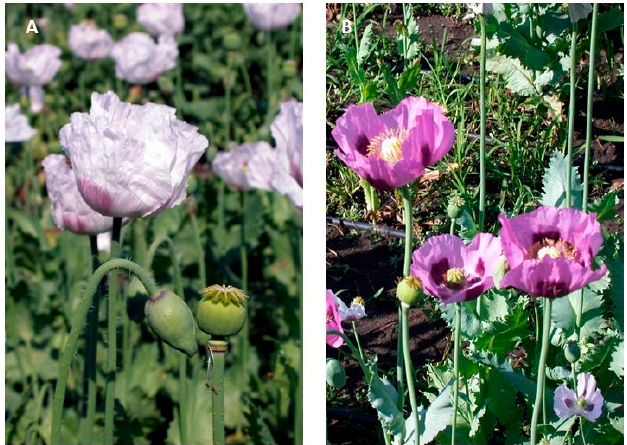
Figure 4. Color of opium poppy flowers may vary from white to purple. An example is shown for light violet flower ( A ) of cultivar ‘Korona’ and for dark purple flower ( B ) of cultivar ‘Leila’ (Photo: Zámboriné Németh, É.).